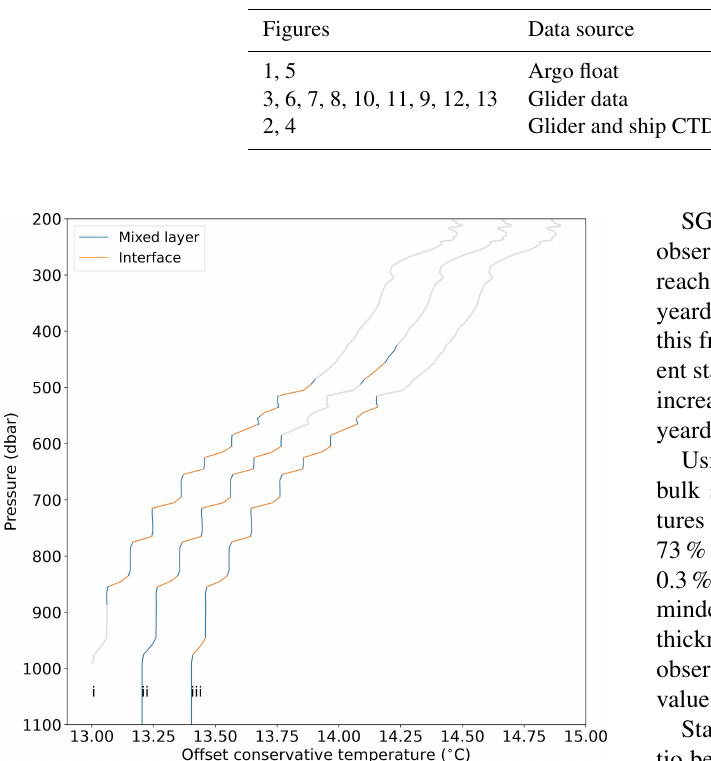
Table 1. Sources of the data displayed in figures.